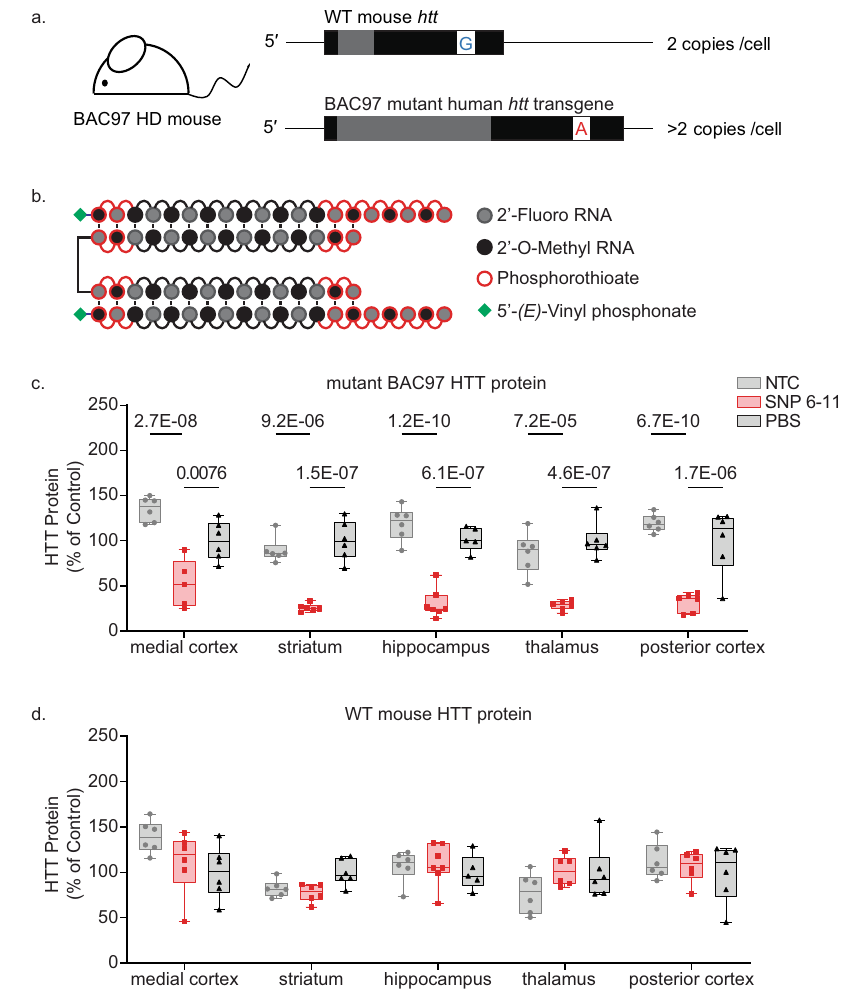
Fig.6|SNP6-11selectivelysilencesmutantHTTinanHDmousemodel.a BAC97 HD mice have a high copy number of transgenic mutant human huntingtin ( Htt